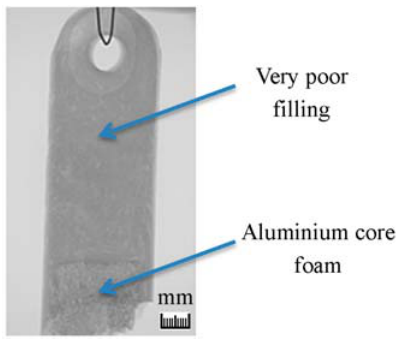
Figure 18. Reduced second phase speed (20 m/s) HPDC cast part.